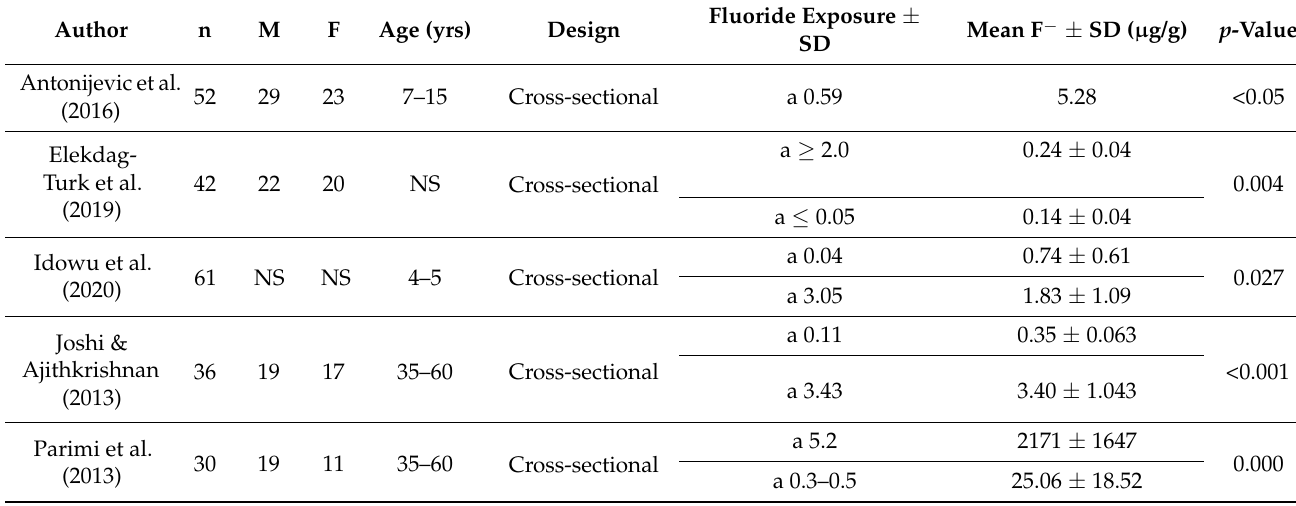
Table 3. Fluoride concentration in hair.